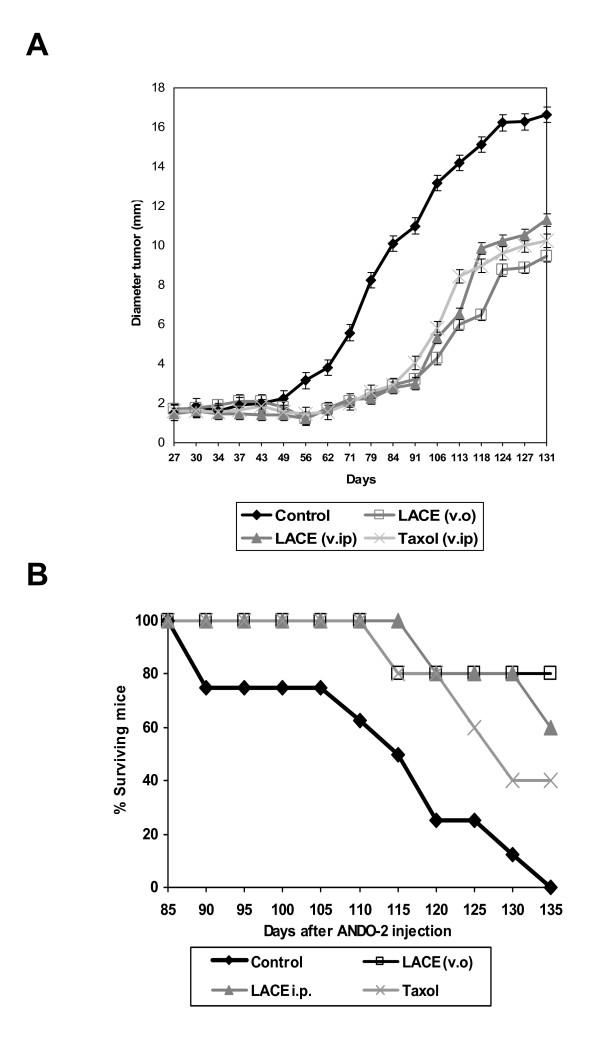
Effect of LACE on the growth of ANDO-2 in nude mice. a) There was not differences between the different control groups, while LACE induced tumor growth inhibition reached to about 60%. The Y-axis represents long tumor diameter and the X-axis represents time (day) after ANDO-2 cell injection. Each data point represents the mean ± SD of three independent experiments. b) Effect of LACE in survival time. The percentage survival was calculated as: % survival = number of survival mice in the test group/number of mice in the group. Data are representative of three independent experiments.